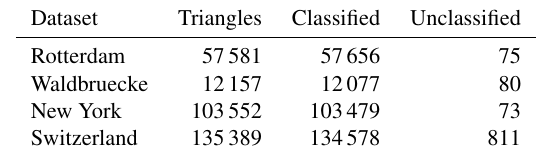
Table 2: Classification matrix: the total number of triangles, the number of classified and the number of unclassified triangles.